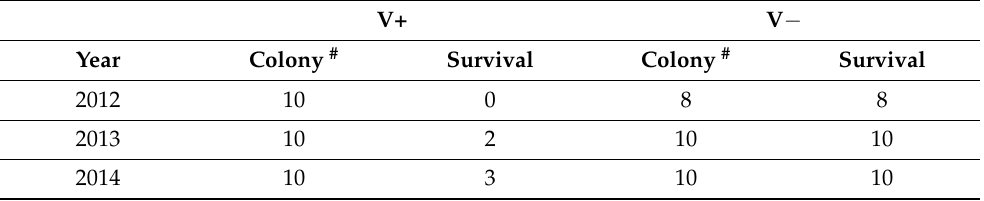
Table 1. Colony survival in March, since the start of experiment in July the year before for colonies without acaricide treatment (V+) or with acaricide treatment (V − ). Colony # indicates the number of starting